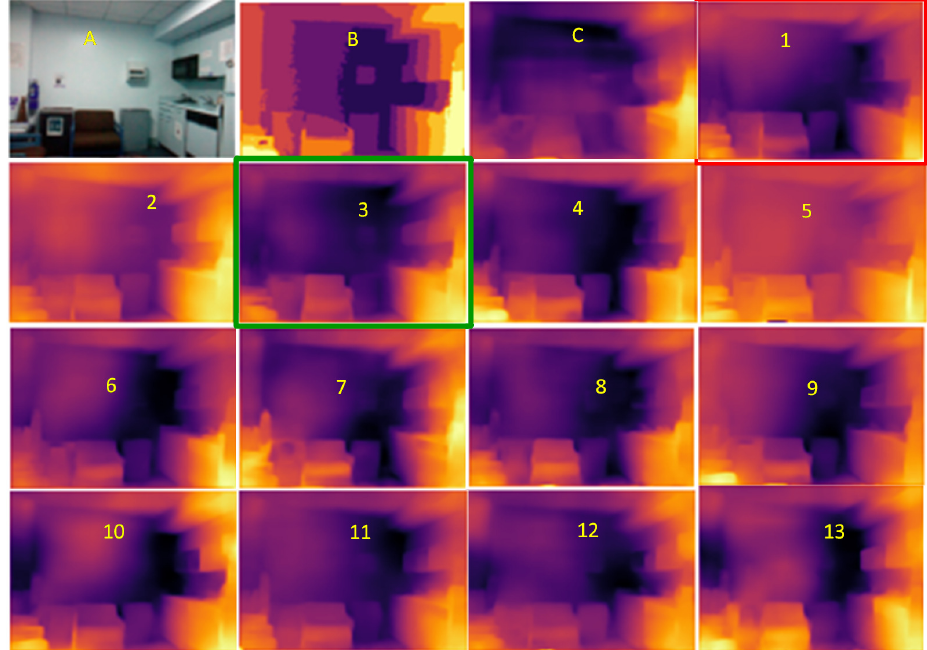
Figure 11. Depth map prediction after training, a visual comparison. A : Input image, B :